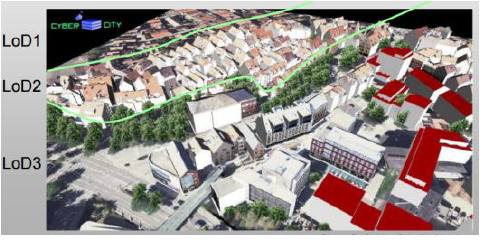
Figure 6 Mixing Levels-of-Detail in one Scene (Kolbe and Gröger,